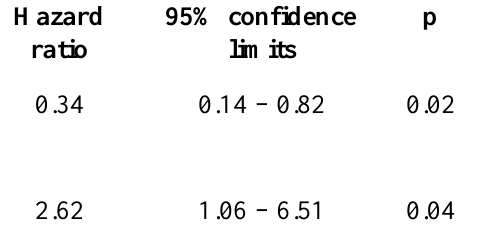
Table 3. Multivariate analysis of prognostic parameters in patients without distant metastase